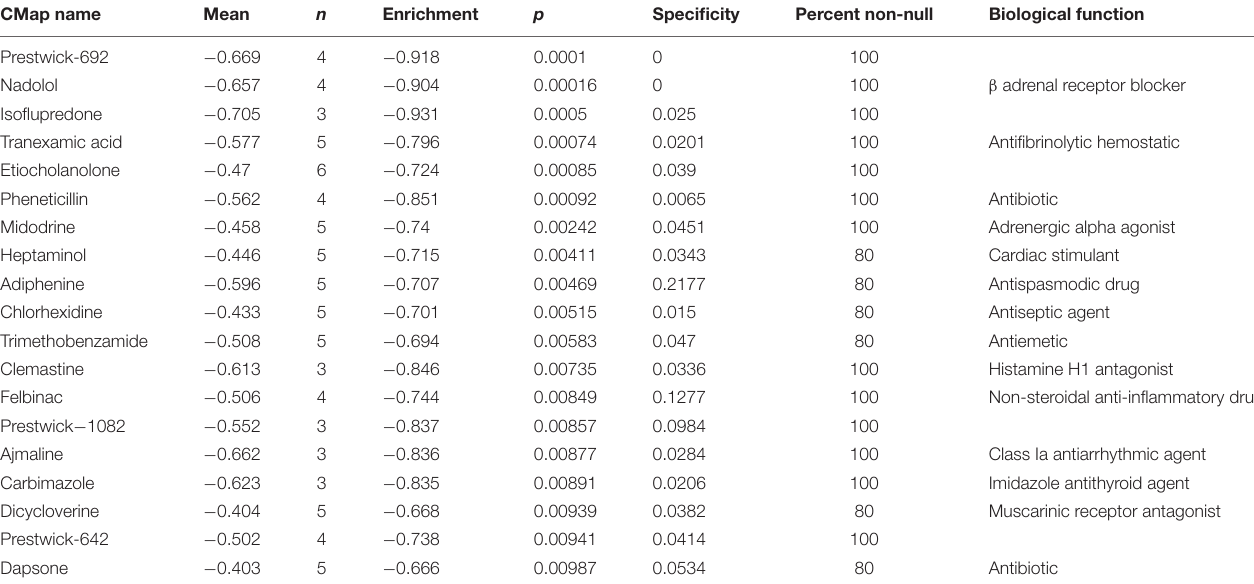
TABLE 2 | The small molecules that can reverse the expression of NNMT and its correlated genes after CMap